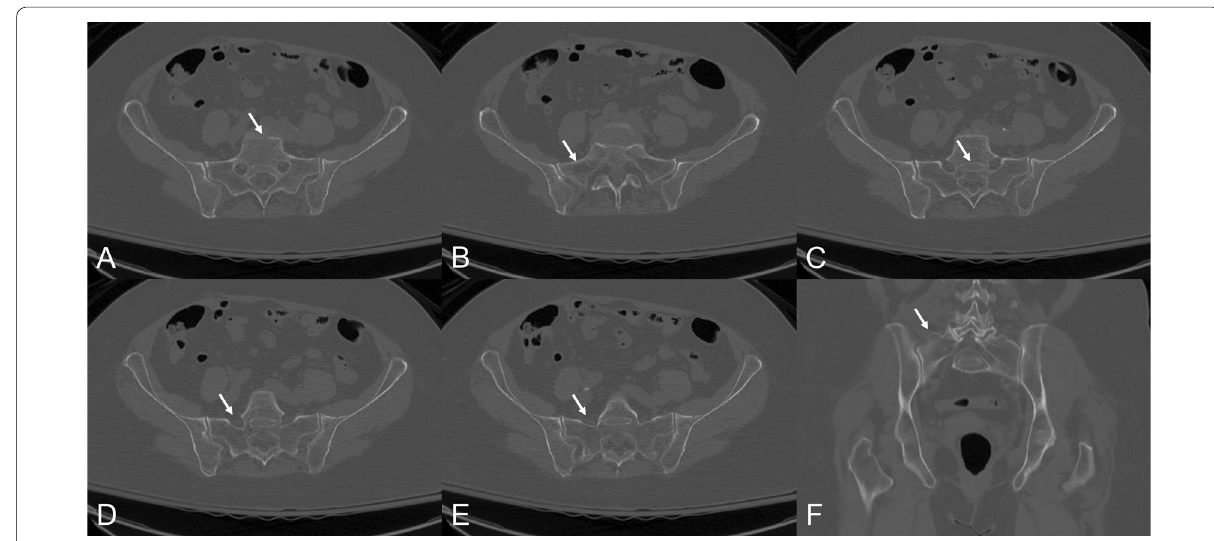
Fig. 1 CT images showing dysmorphic features. Axial images demonstrate: ( a ) S1 not recessed in the pelvis, ( b ) acute alar slope, ( c ) residual disk, and ( d , e ) misshapen sacral foramina. Coronal imaging demonstrates ( f ) mammillary